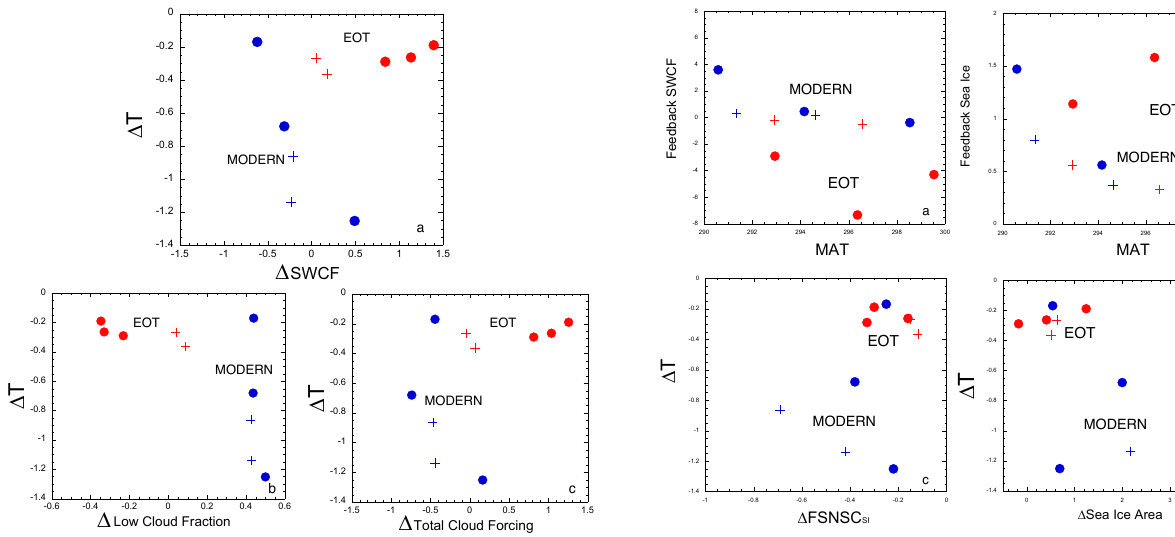
Fig. 8. Cloud related variables plotted with same conventions as Fig. 5. (a) The anomalous SWCF (Wm − 2 ) compared with 1T . Figure 7. Same colored dots and crosses described in Figure 4 (Table 1). a) The anomalous SWCF forcing (b) The low cloud fraction anomaly in (%) (averaged from 60 ◦ S anomaly ( Wm -2 ) along the x-axis, compared against Δ T along the y-axis. b) The anomalous low fraction to 90 ◦ N) compared with 1T . (c) The total cloud forcing anomaly (averaged from 60˚S to 90˚N in the cases where we changed Antarctic topography) ( % ) along the x-axis, compared against Δ T along the y-axis. c) The anomalous total cloud forcing anomaly ( Wm -2 ) along the x-axis, (Wm − 2 ) compared with 1T . compared against Δ T along the y-axis.